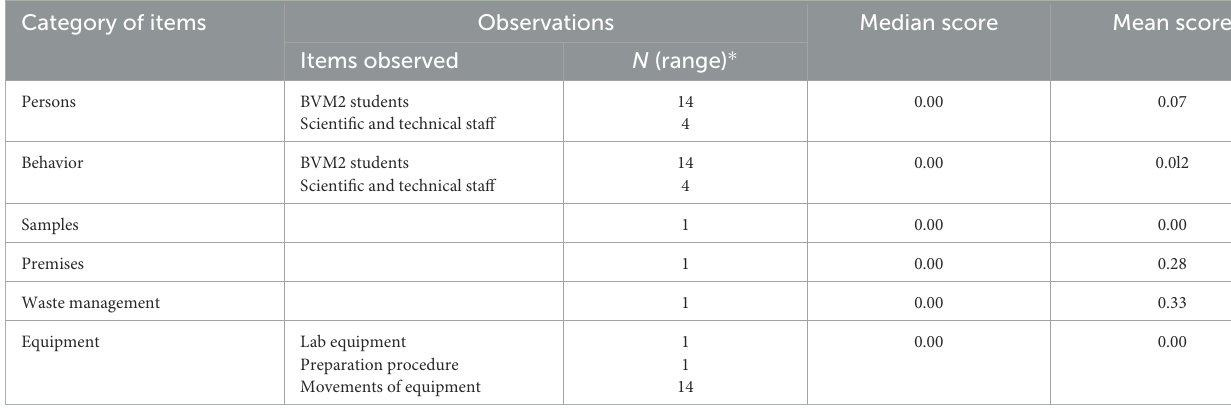
TABLE 3 Practical virology sessions—mean and median scores per category of